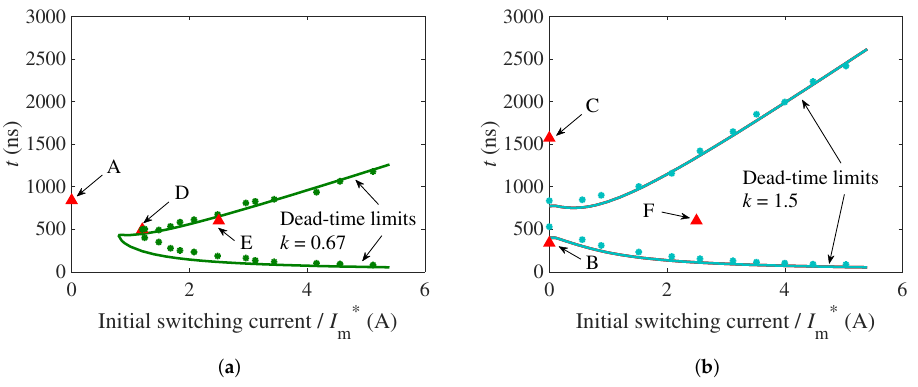
Figure 8. Lower and upper limits of the dead-time duration for ZVS shown as solid lines, and experimentally measured boundary operating points shown as star marks in the conditions of ( a ) k = 0.67 ( E dc > 0), and ( b ) k = 1.5 ( E dc < 0). Some example operating points discussed in this section are marked as A, B, C, and D, and resulting settings for operations are marked as E and